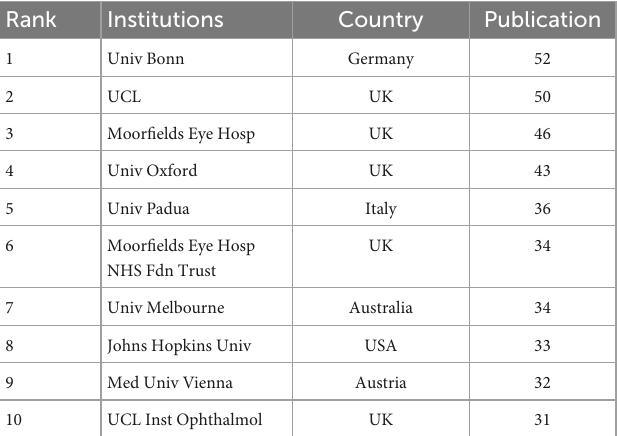
TABLE 5 The top 10 most productive institutions. Figure 13 concludes the keywords of microperimetry research by wordcloud.